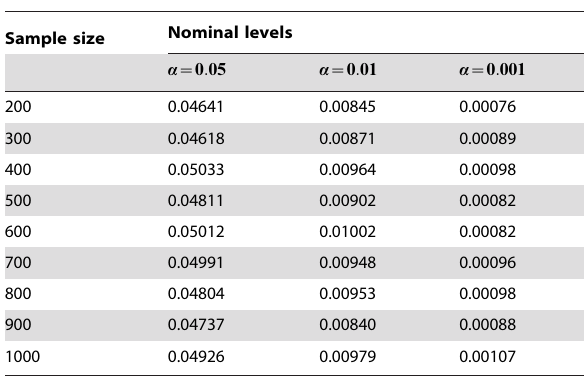
for 400 cases 3 E